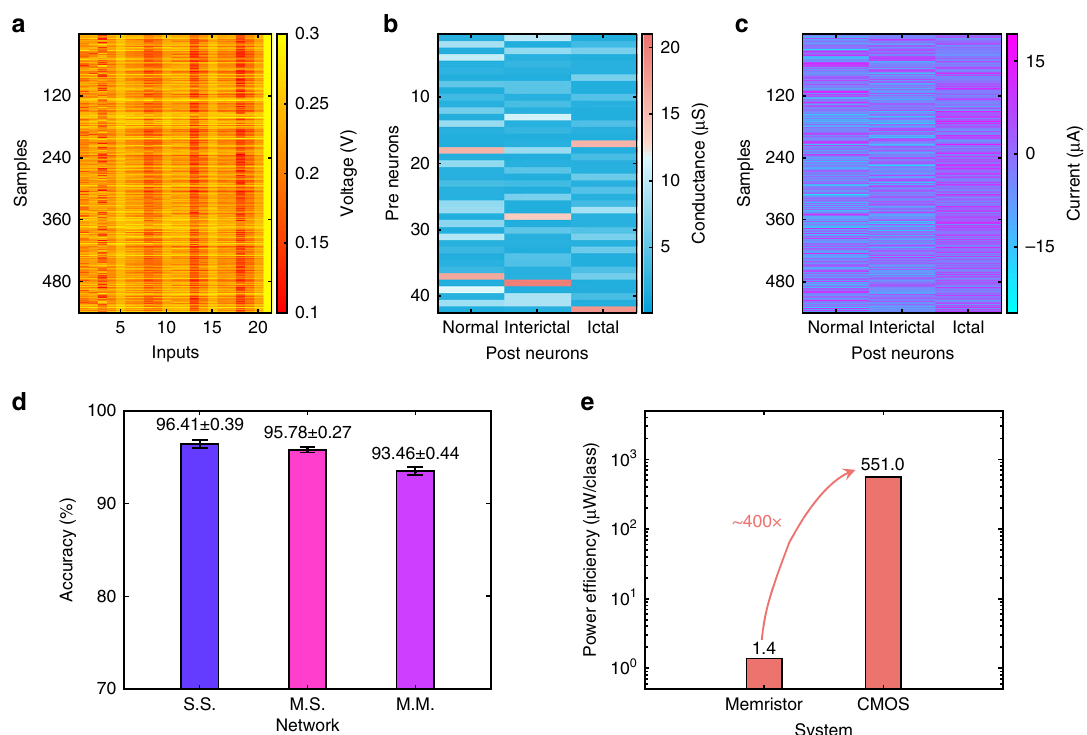
Fig. 4 Results of the memristor array-based neural network for neural signal identi fi cation. a Input voltages transformed from the extracted biomarker vectors to be applied on the memristor array-implemented neural network. b Conductance map of the memristor array for the single-layer perceptron neural network. c Output current of the neural network. The output neuron with the largest current value shows the input signal type. d Overall accuracies of the software-simulated and memristor array-implemented neural networks in the identi fi cation of the brain state. Here, error bars represent the standard deviations. S.S. represents the network trained using software-calculated results. For M.S. and M.M., the networks are trained using memristor array- fi ltered results, and M.S. uses the software-simulated network while M.M. uses the memristor-implemented network for inference. e Comparison of the power ef fi ciency for CMOS-based and memristor-based systems. Source data are provided as a Source Data fi suf fi cient information for identi fi cation and it performs as well as